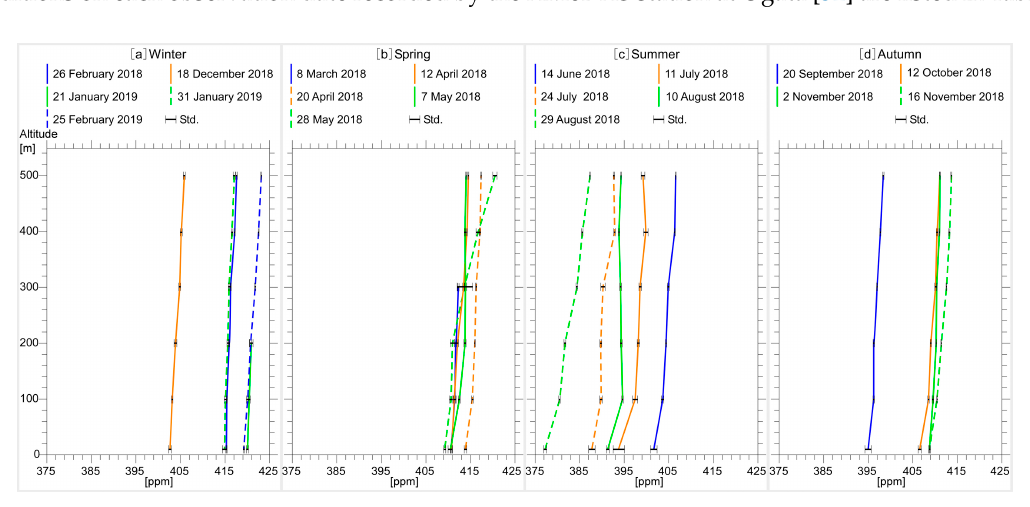
Figure 5. Vertical profiles of CO 2 from 10 m to 500 m elevation. ( a ) Winter, ( b ) spring, ( c ) summer, and ( d ) autumn. The dots are used to show the mean CO 2 concentration during the 30-s measurement period at each altitude, and the error bars indicate standard deviations.